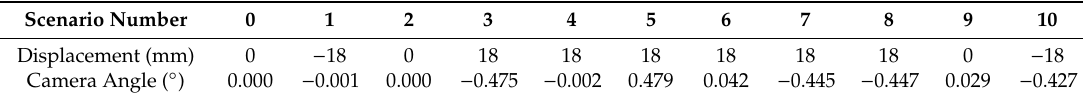
Table 5. Marker displacement and camera movement angle in Scenario 4.